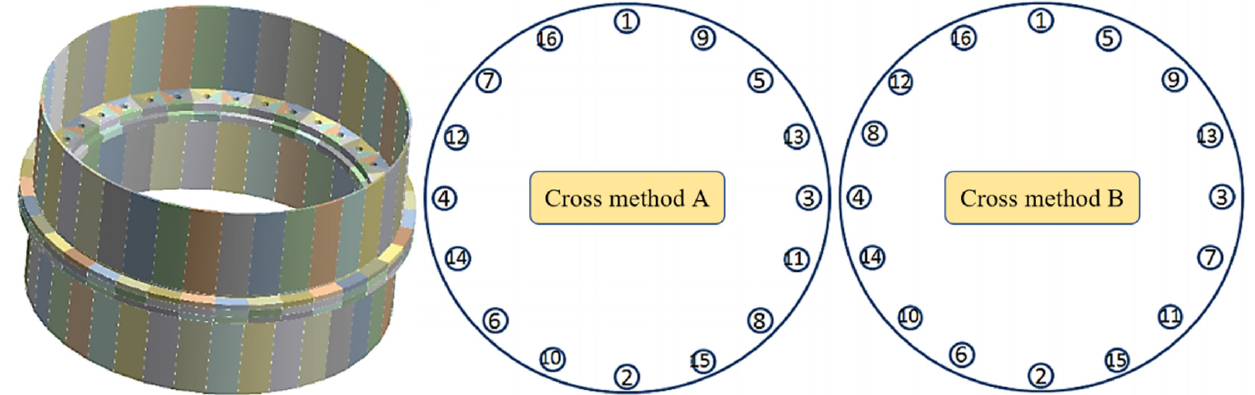
Figure 10. Finite element model of 16 bolts and the sequence diagrams of cross-tightening methods A and B [54].